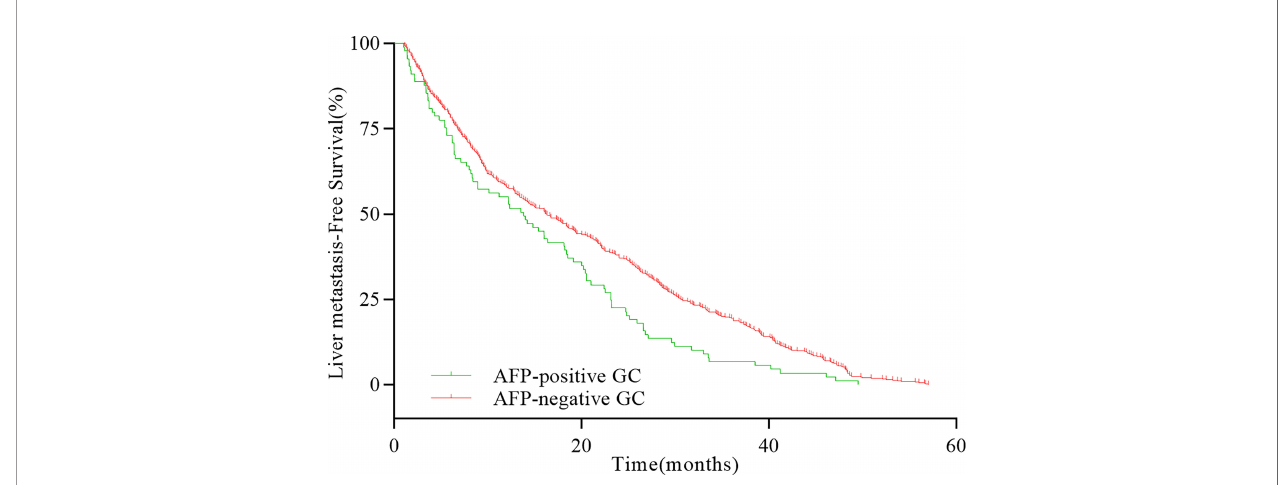
FIGURE 2 | Comparison of LMFS rates between AFP-positive GC and AFP-negative GC with liver metastases ( P =